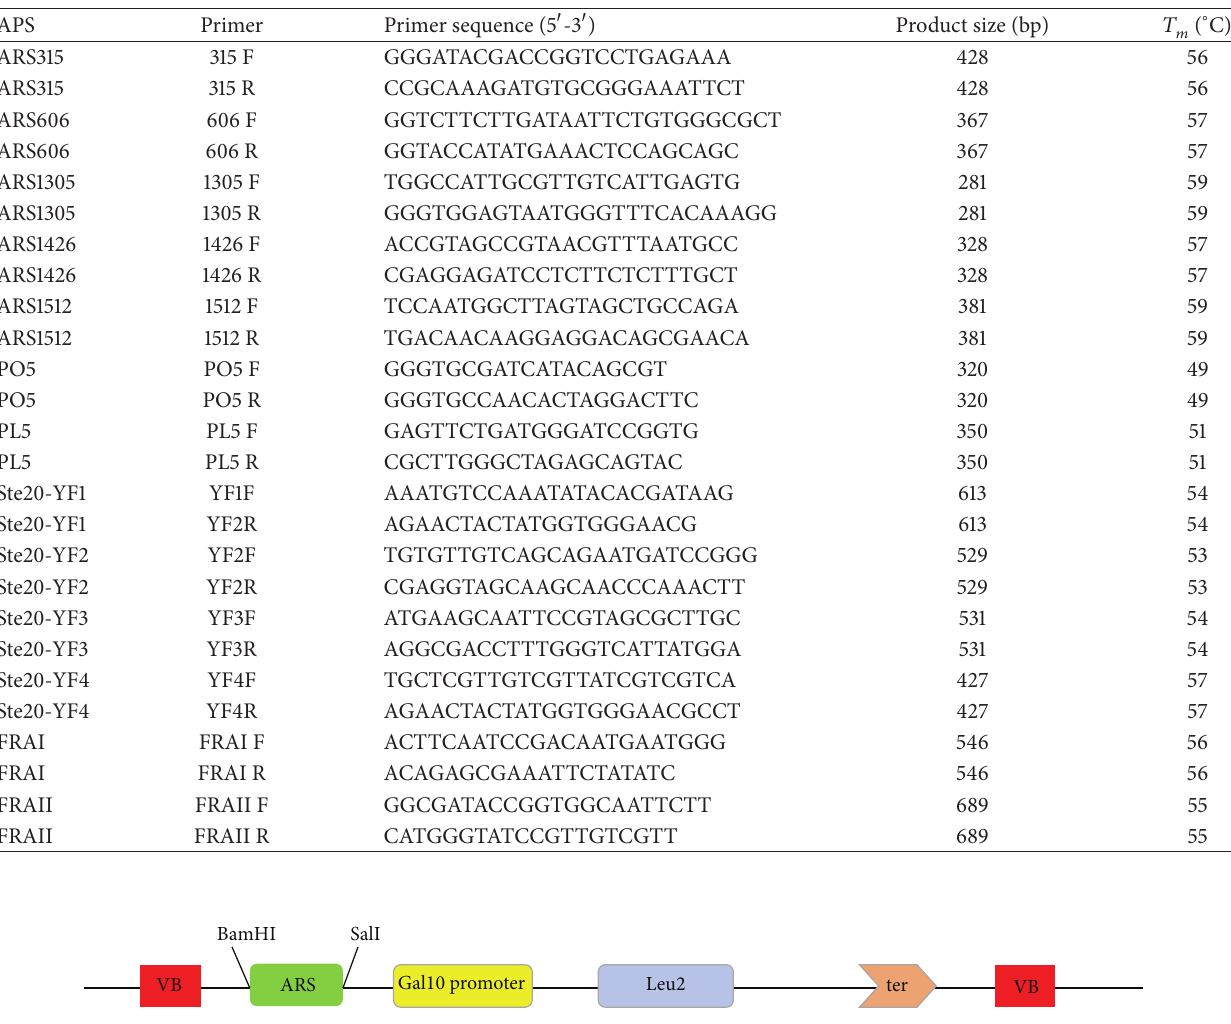
Figure 1: Cloning of amplification promoting sequences. The vector used for cloning APS sequences was the yeast episomal plasmid YEp51.